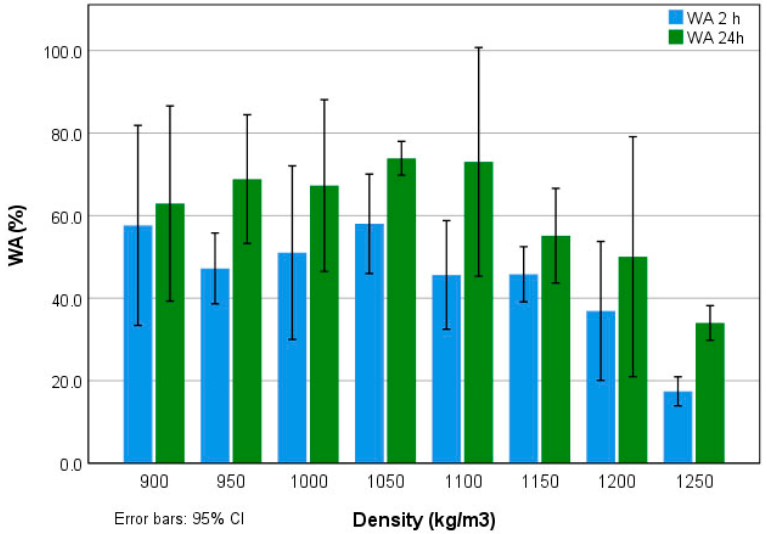
Figure 3. Water absorption (WA) after 2 and 24 h of the experimental panels. European standards [33] do not apply to this